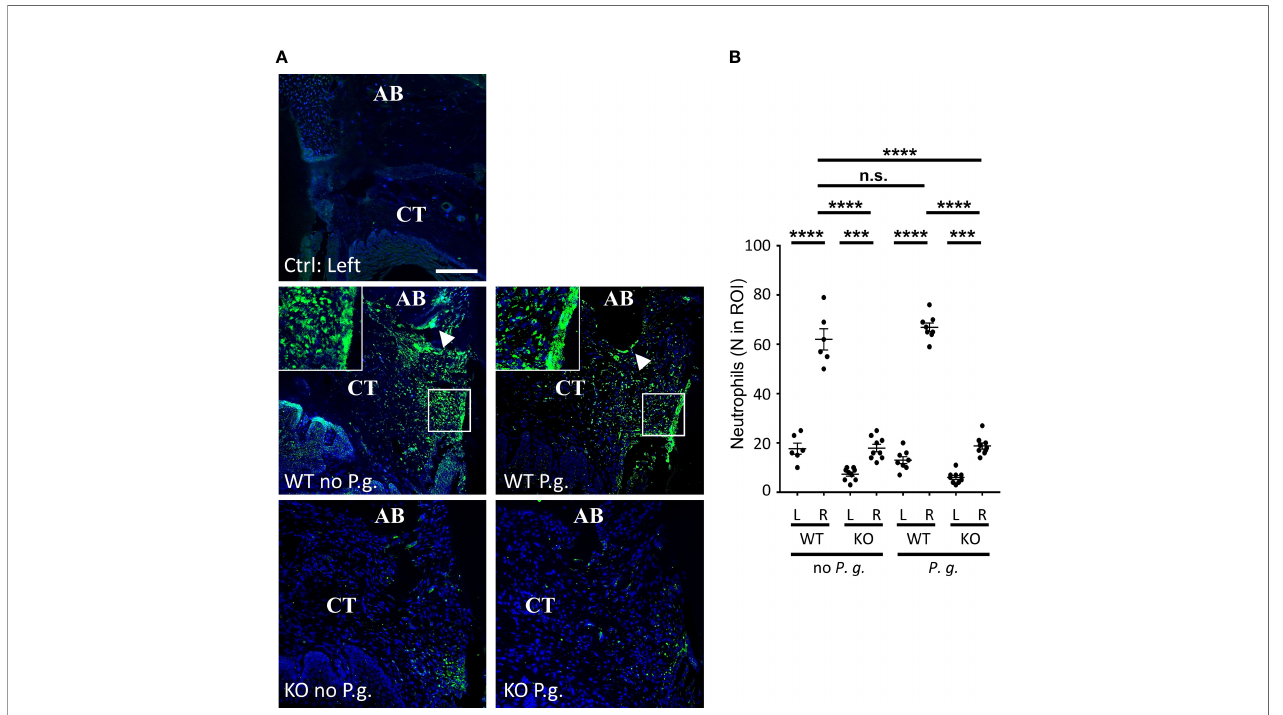
FIGURE 7 | Neutrophils in fi ltrate connective tissue dependently of NLRP3 expression. (A) Neutrophils were detected by immuno fl uorescence using a speci fi c antibody. The control without periodontitis induction (left side) is shown on the individual upper panel, the assays with ligature with or without P. gingivalis (right side) are shown on the 4 lower panels. Enlargements show the “ Neutrophil wall ” , close to the site of periodontitis induction. White arrowheads show neutrophils along alveolar bone (CT = connective tissue, AB = alveolar bone), scale bar = 100 m m. (B) The number of neutrophils was counted in a 0.082 mm 2 area (ROI) surrounding the alveolar bone crest. Each dot represents a single mouse. Horizontal bars represent the mean +/- SEM. Ordinary one-way ANOVA followed by uncorrected Fisher ’ s LSD with a single pooled variance multiple comparison test. ***P < 0.001, ****P < 0.0001, n.s. P ≥ 0.05, non-signi fi